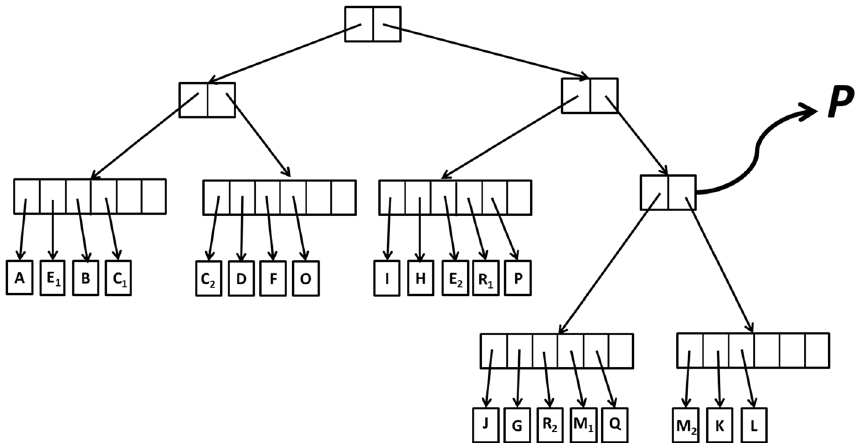
Fig. 4 SKDTree corresponding to data